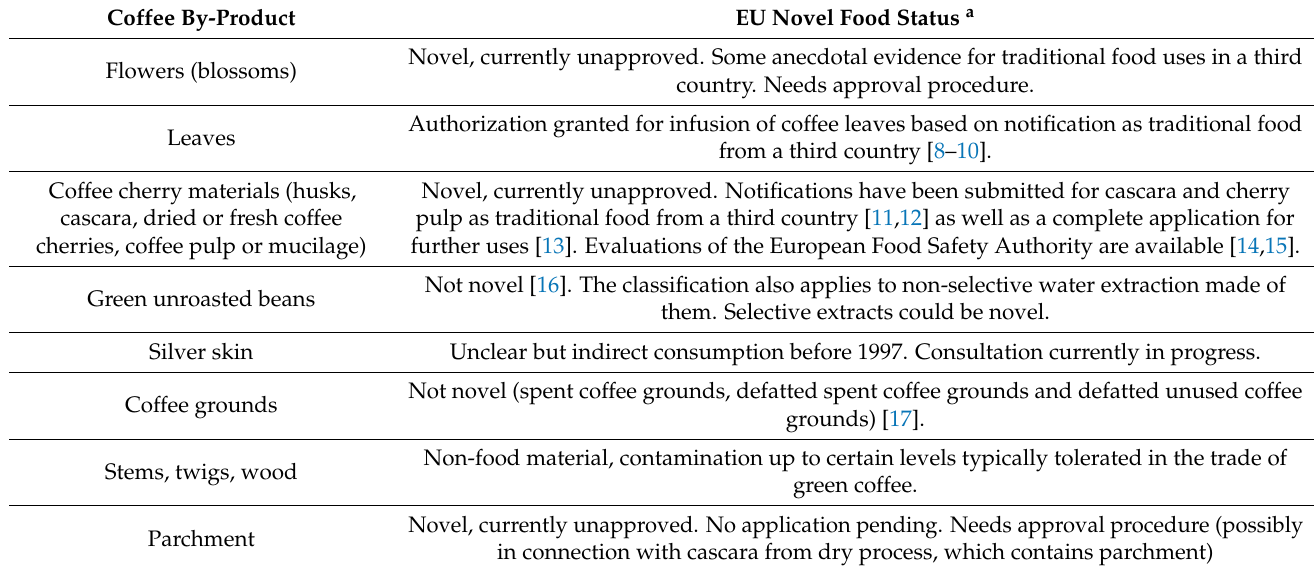
Table 1. Coffee by-products and assessment of their novel food status in the European Union (EU) considering regulation (EU) No 2015/2283 (updated with permission from Klingel et al. [5] and Lachenmeier et al.